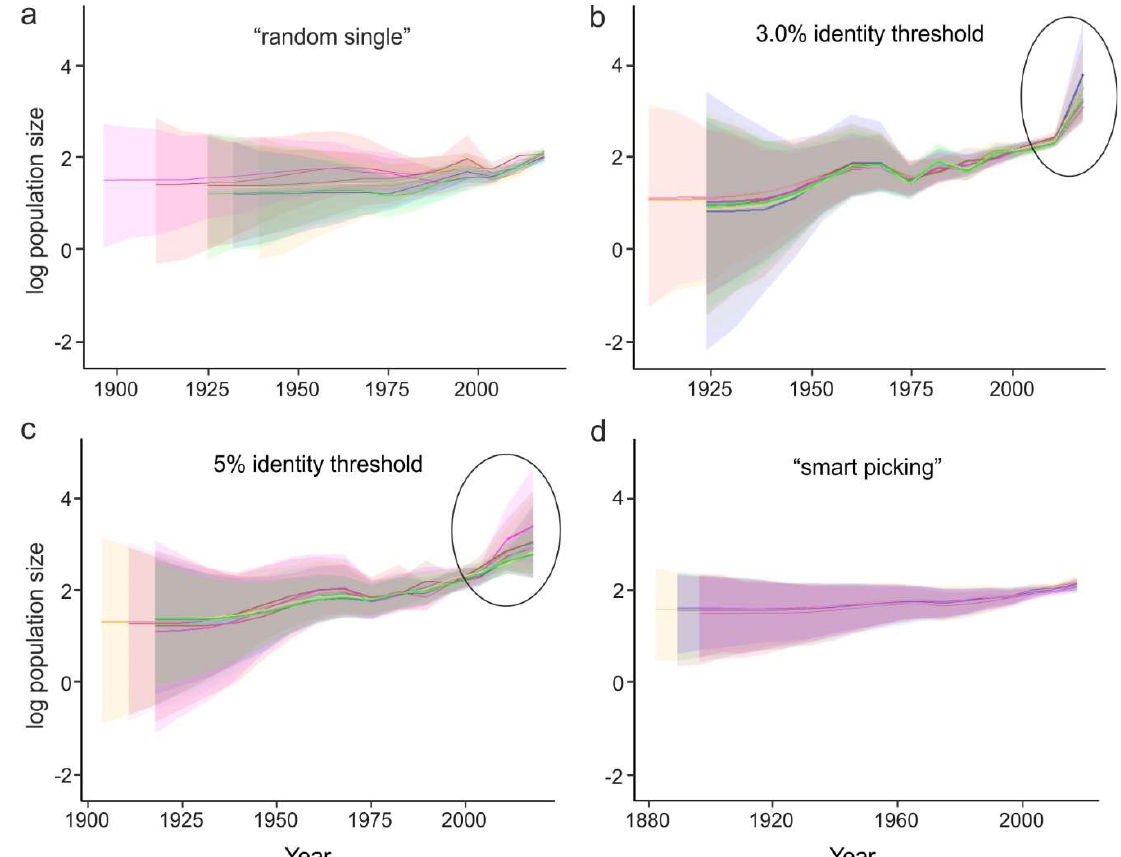
Figure 5. The effect of the dataset preparation algorithm on the results of population dynamics reconstruction using the Bayesian Skygrid model. Random picking of 400 random sequences ( a ), identity filtration with 3% ( b ) and 5% ( c ) identity threshold; “smart picking” algorithm ( d ). Ten repetitions of each sampling algorithm are shown in different colors. Shaded areas indicate 95% high probability density intervals. Similar sequence removal caused a false explosive population growth at a time corresponding to the cut-off threshold (circled).